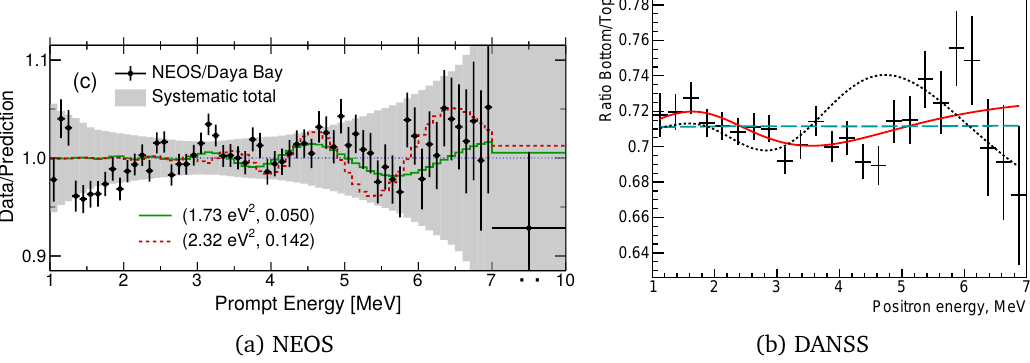
Figure 6: Reactor antineutrino spectra measured by the NEOS [ 19 ] and DANSS [ 20 ] experiments. Both of them see an energy-dependent flavor transition probability that can be fitted by neutrino oscillations, independently of any theoretical flux calcula- tion.